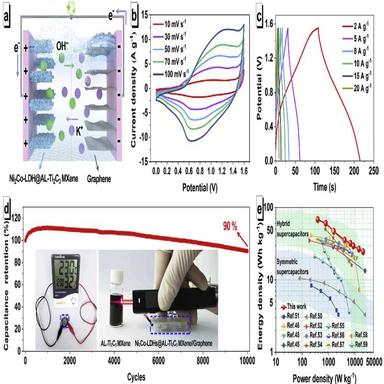
(a) Schematic illustration of the fabricated HSCs device using Ni2Co-LDHs@AL-Ti3C2 MXene as positive electrode and graphene hydrogels as negative electrode. (b) CV curves of the HSCs at various scan rates. (c) GCD curves of the HSCs at different current densities. (d) Cycling stability of the HSCs device at 5 A g1 . The insets are the photographs of the electronic display powered by HSCs (the left) and atomic layered Ti3C2 MXene suspension irradiated by laser pointer driven by two tandem devices. (e) Ragone